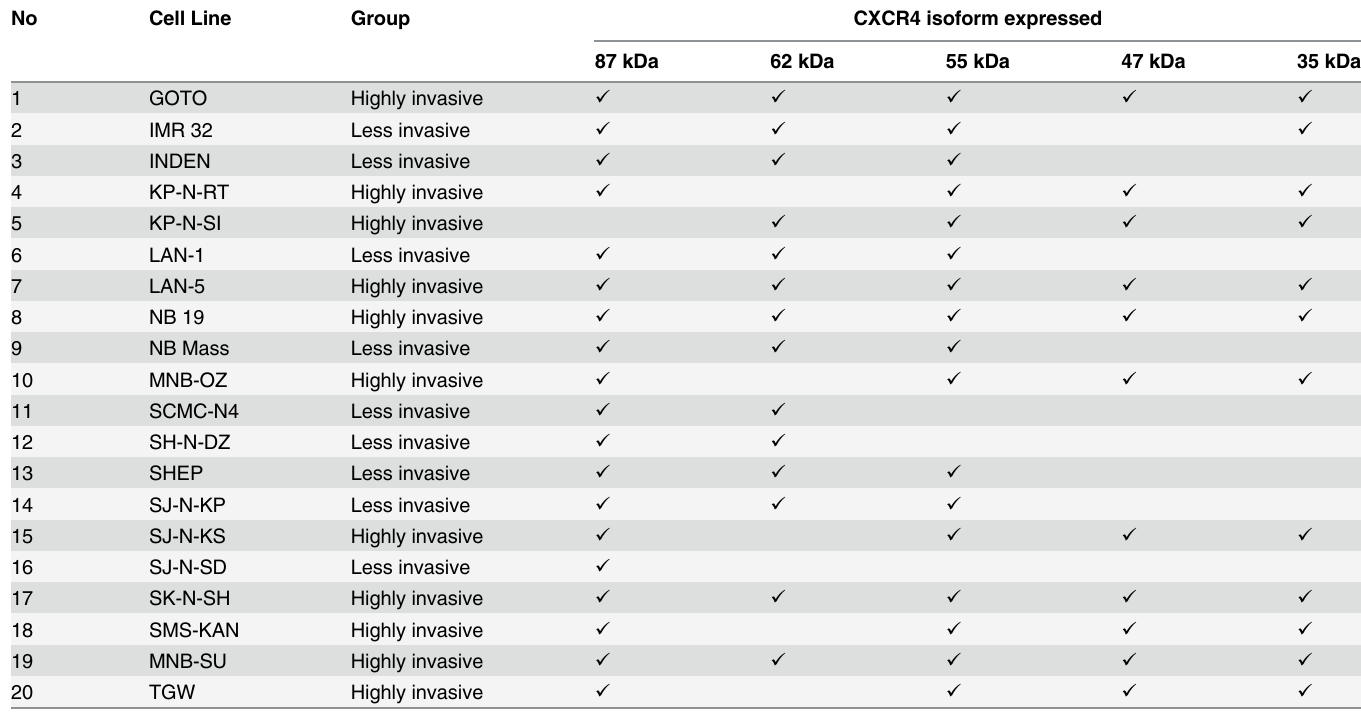
Table 3. Invasion potential and CXCR4 isoforms expressed in neuroblastoma cell